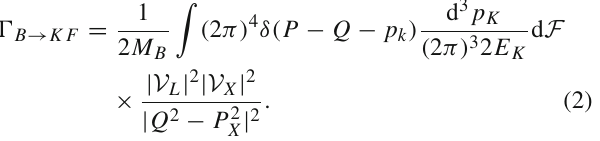
where V L and V X refer to the vertices from left to right in Fig. 1, Q 2 is the invariant mass squared of the